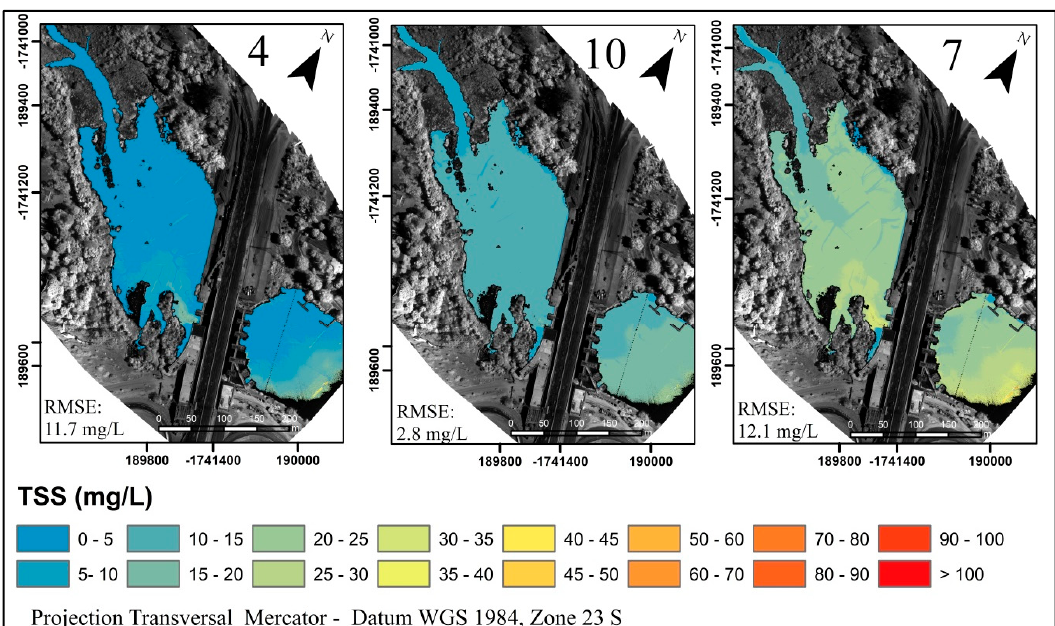
Figure 15. 2018 / 09 / 12 TSS maps in the Parano á from models using green and red bands (models are Figure 15. 2018/09/12 TSS maps in the Paranoá from models using green and red bands (models are labeled following Table labeled following Table 4).